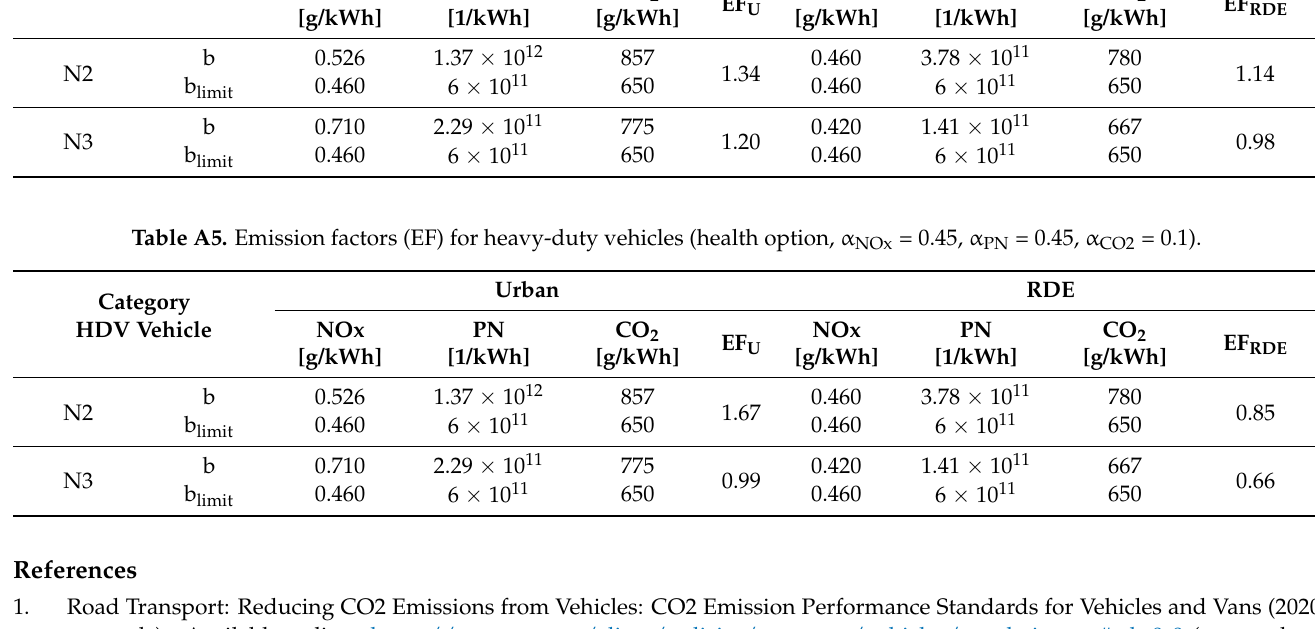
Table A4. Emission factors (EF) for heavy-duty vehicles (environmental option, α NOx = 0.15, α PN = 0.05, α CO2 = 0.8). Category HDV Vehicle